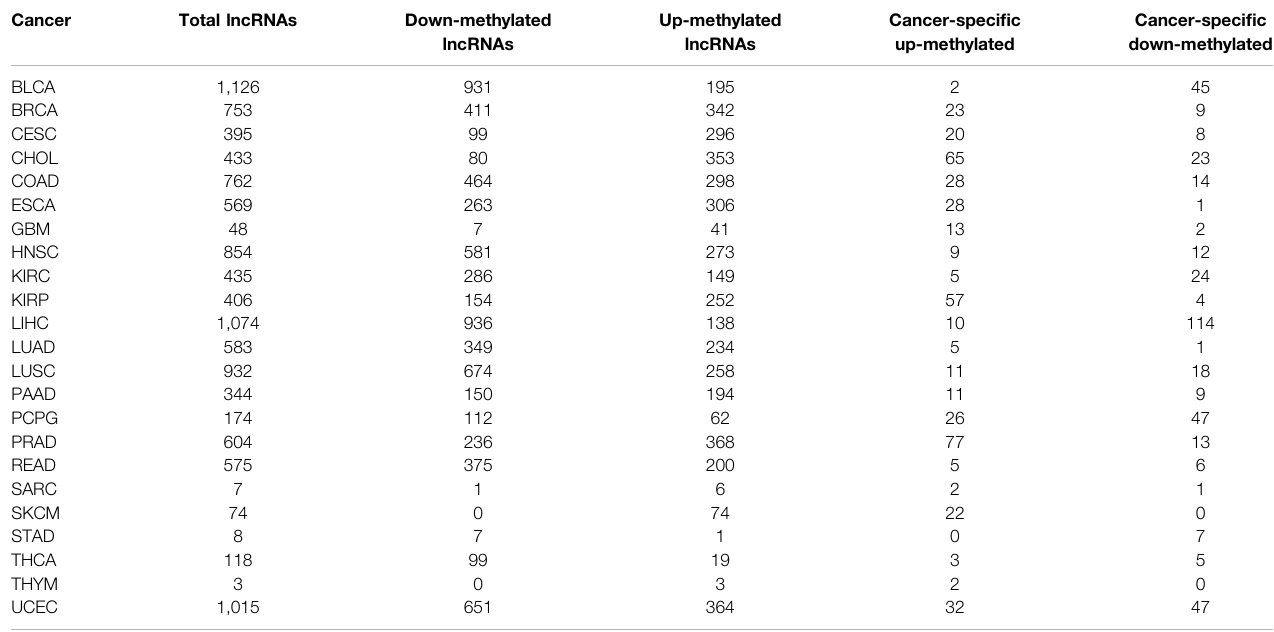
TABLE 2 | The number of DMlncs of each